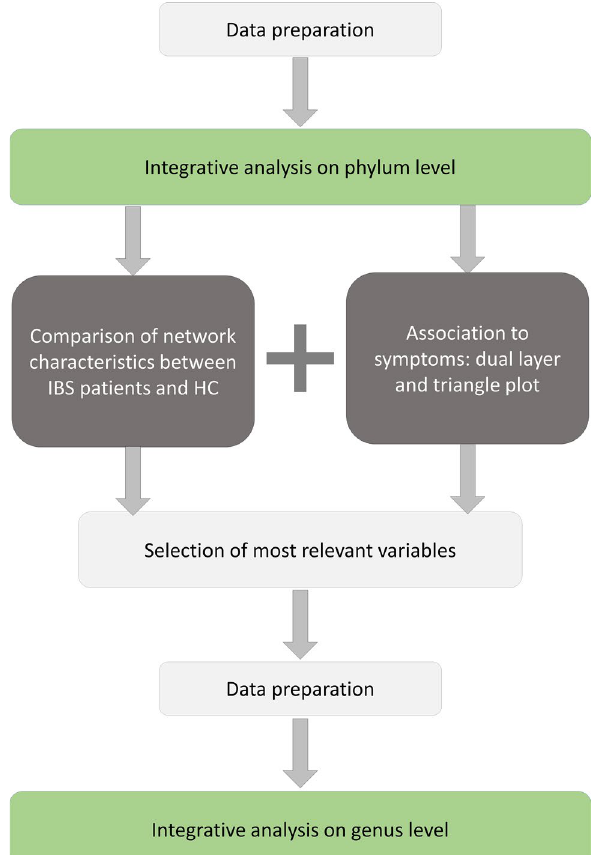
Figure 1. Overview of the steps performed for analyzing the pilot study